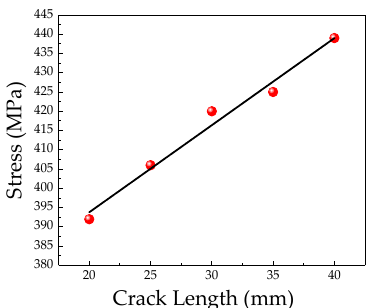
Figure 10. Relationship between the stress at crack tip and the crack length.